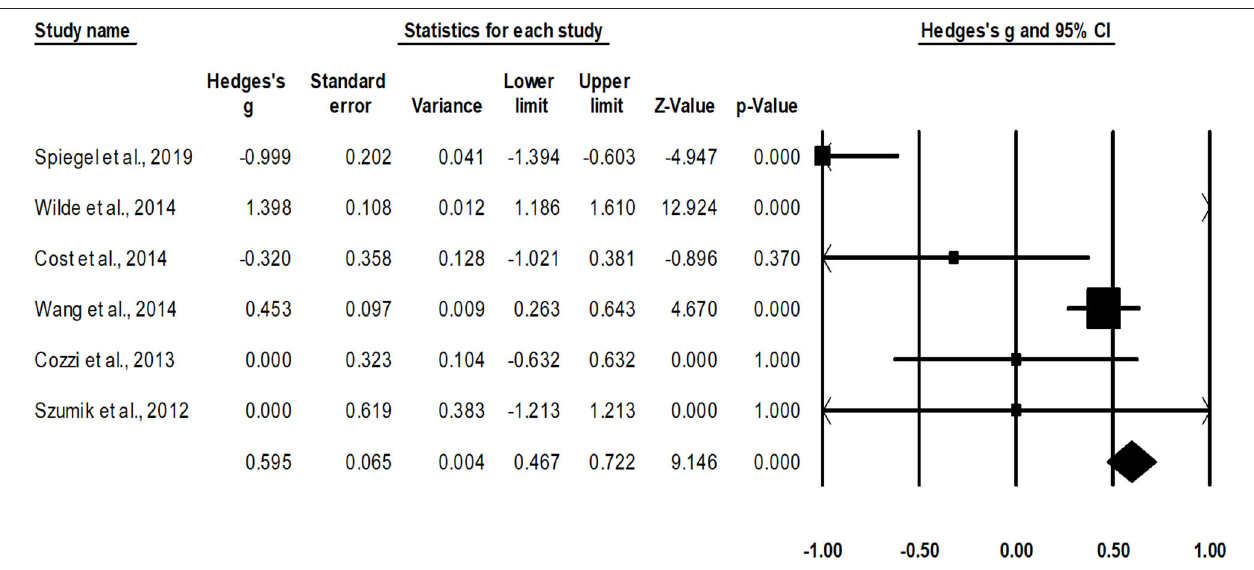
nephrectomy after a mean follow-up of 2.1 years. Likewise, Kern et al. (41) and Cozzi et al. (39) reported a reduction in glomerular filtration rate after radical nephrectomy. The authors mentioned an inverse relationship between a longer follow-up and renal function postsurgery. In the present meta-analysis, we too observed that the renal function was negatively affected (eGFR, − 0.16; mean follow-up, 10.6 years) in cases undergoing radical